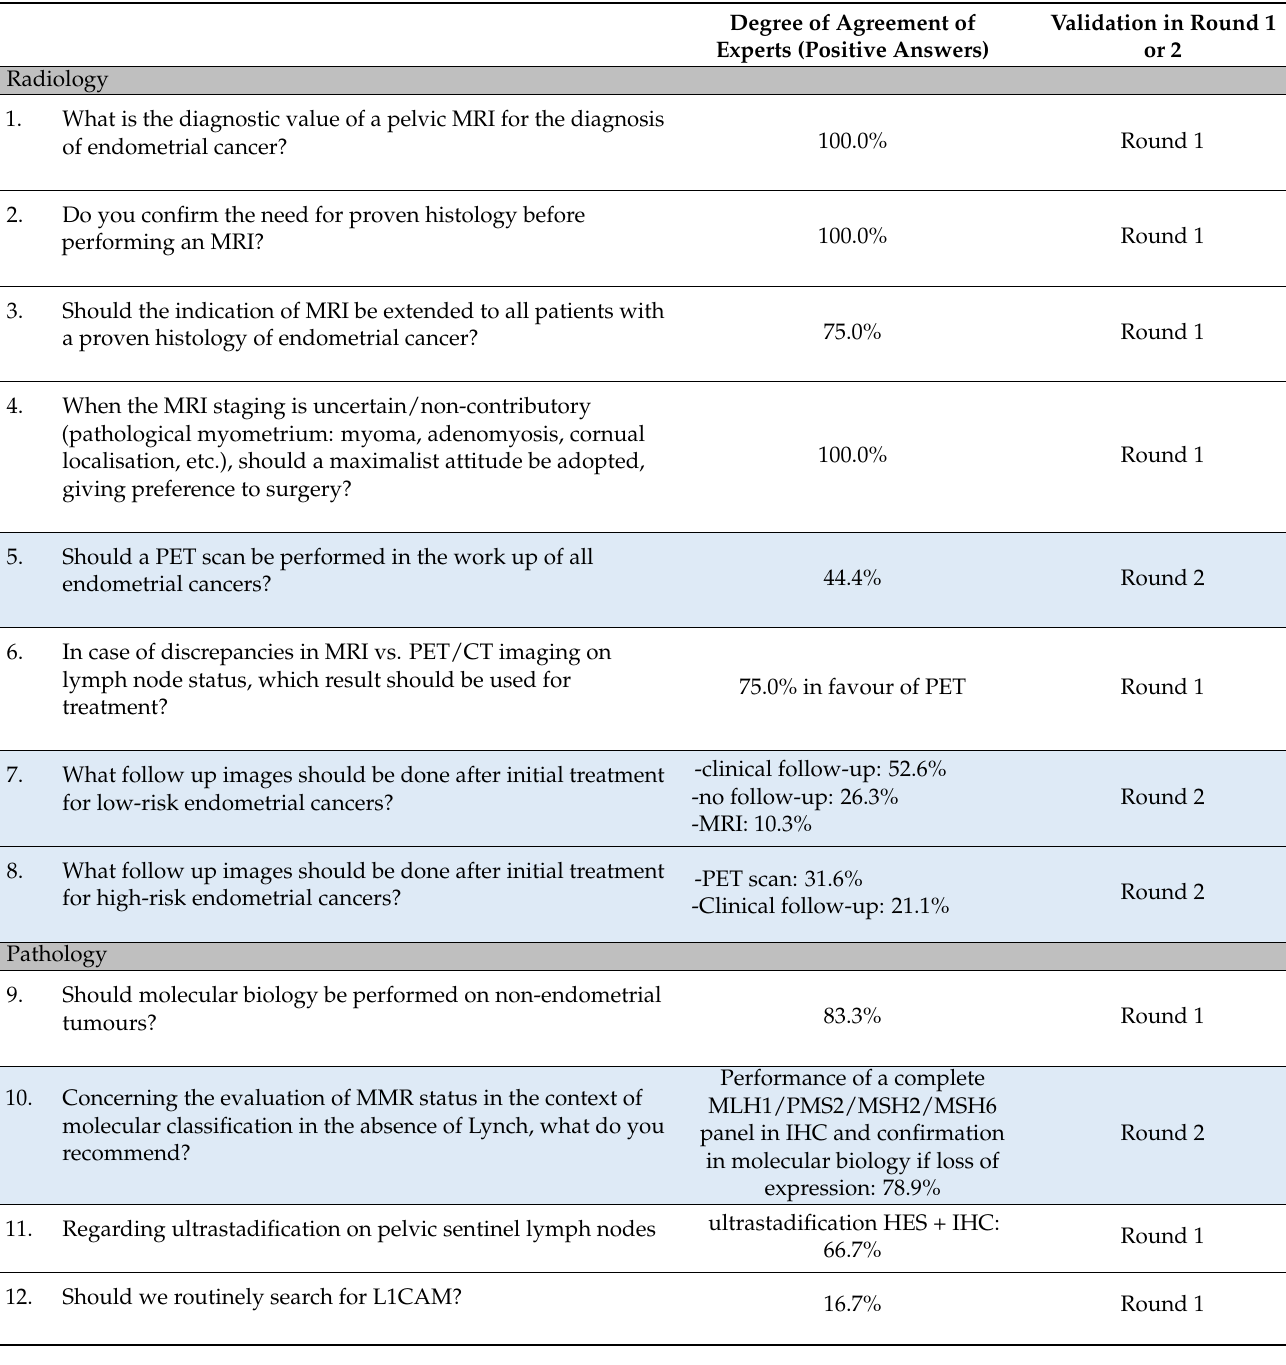
Table 1. List of Delphi